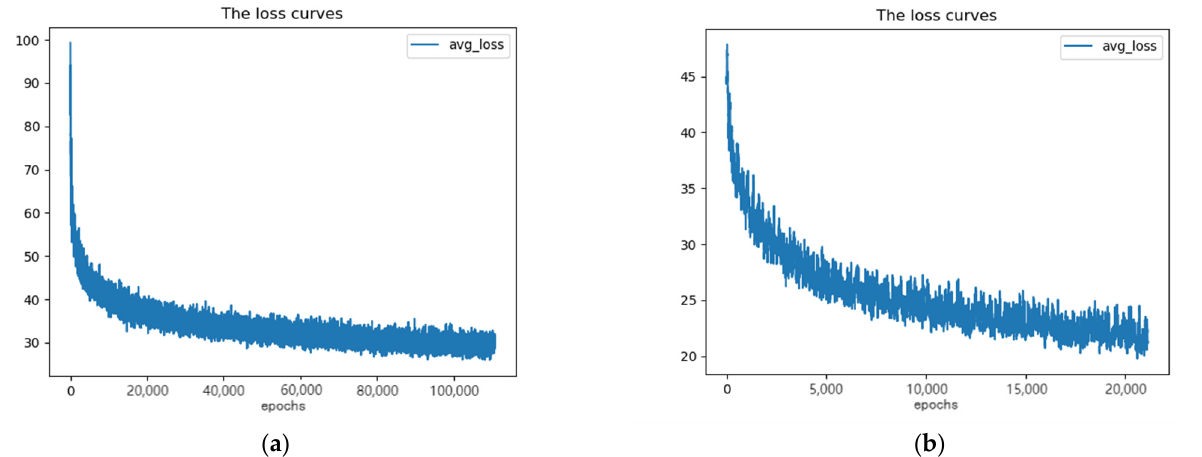
Figure 9. Loss curves during training: ( a ) Loss value for training 100,000 iterations. ( b ) Loss value for training 20,000 iterations.